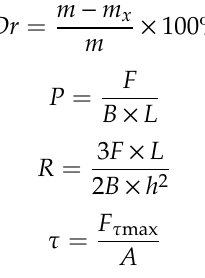
Figure 4. Order of the experiment.